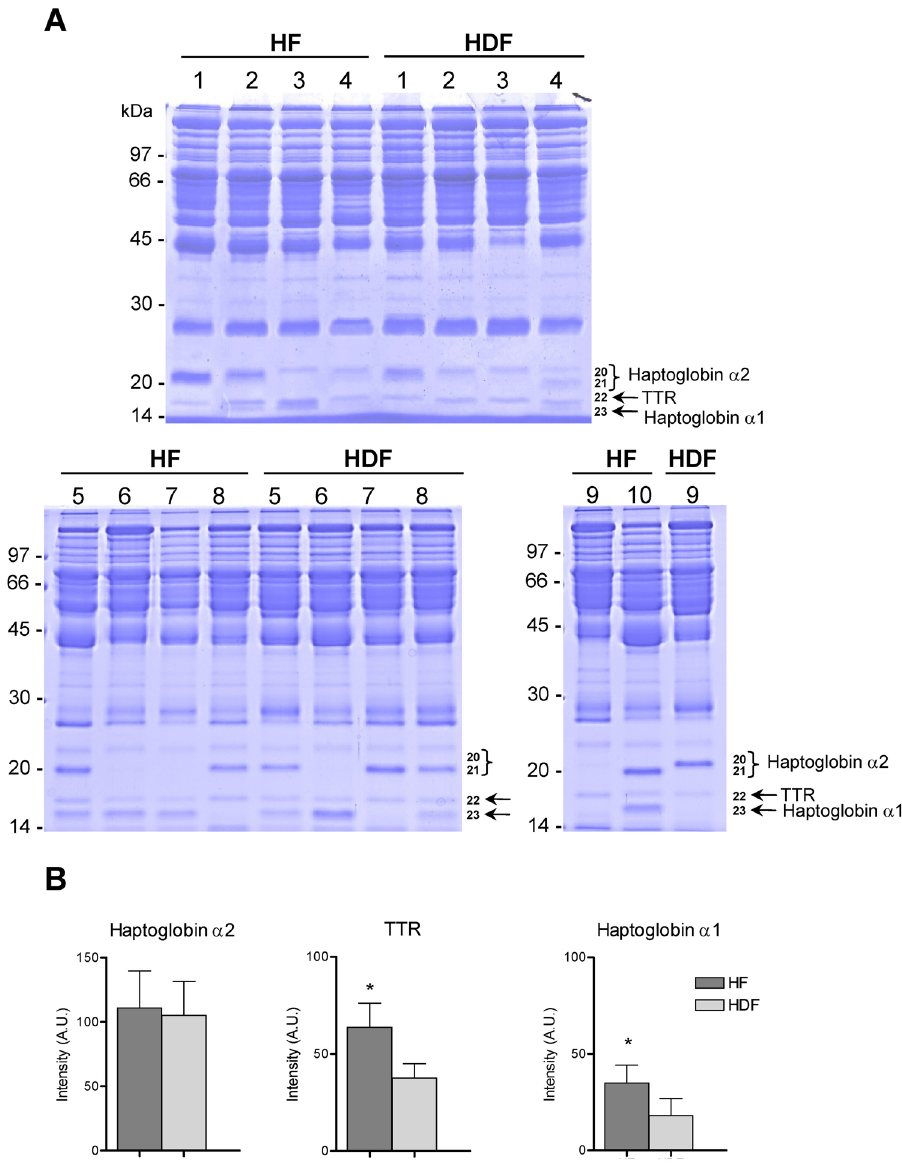
Figure 3. Transthyretin detection in individual HF and HDF patients’ plasma samples. ( A ) Individual albumin- and IgG-depleted plasma samples from each HF and HDF patient were analysed independently by SDS-PAGE and stained with Coomassie blue. Proteins haptoglobin α2 (20 and 21), transthyretin (22) and haptoglobin α1 (23) were identified by MALDI-TOF MS. The figure shows stained whole gels corresponding to HF and HDF patients. The numbers on the left indicate the apparent molecular mass in kDa. ( B ) Quantification of haptoglobin α2, transthyretin (TTR), and haptoglobin α1 (arbitrary units, A.U.). Graphs show the proteins levels in HF and HDF samples represented as the mean of the 10 and 9 samples, respectively. Error bars indicate SE; * p < 0.05, HF compared with HDF by